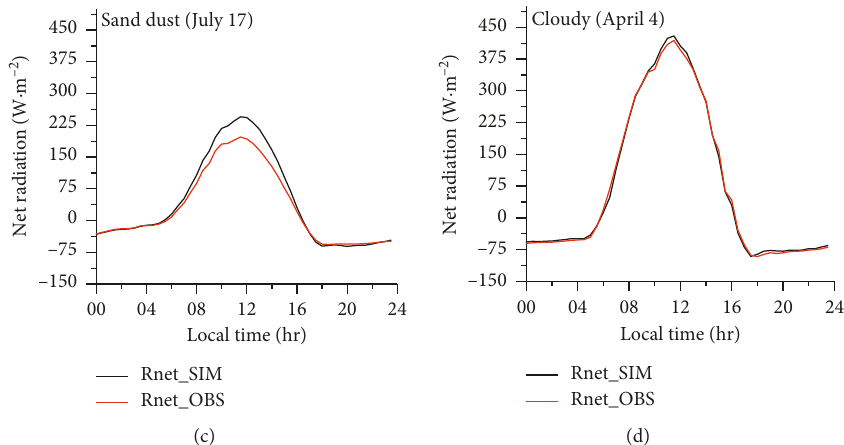
Figure 12: Contrast curve between the simulated (black) and observed (red) net radiation ( R Tazhong station in